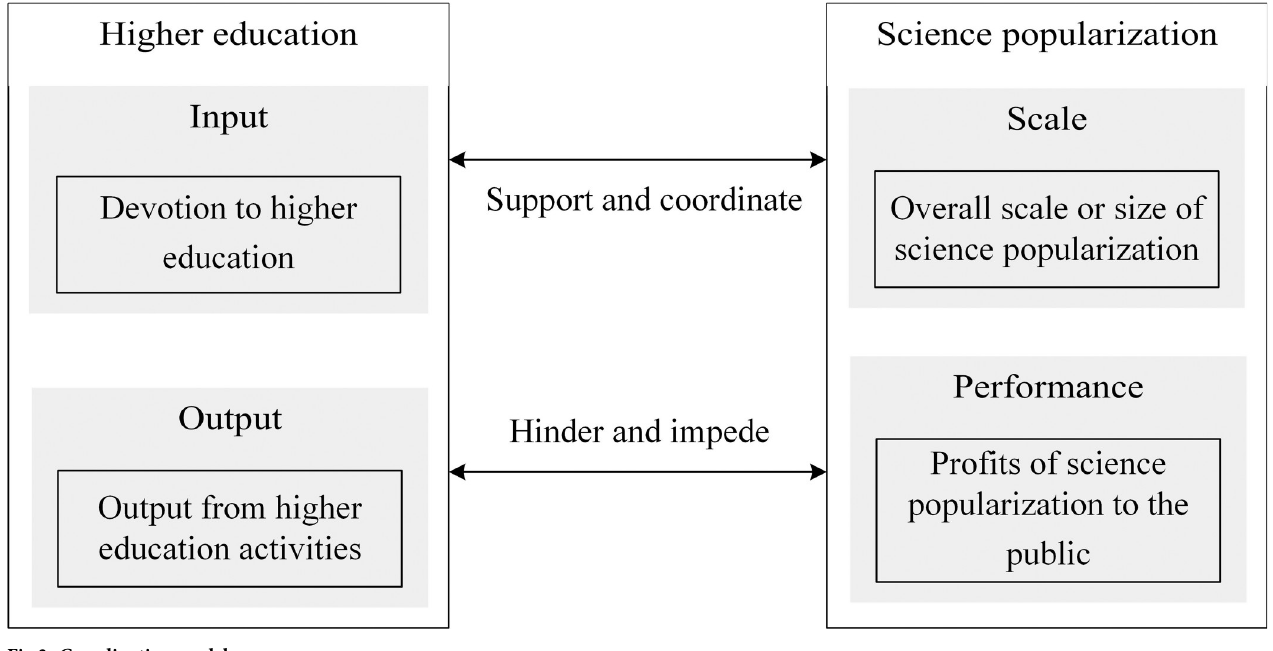
Fig 3. Coordination model.